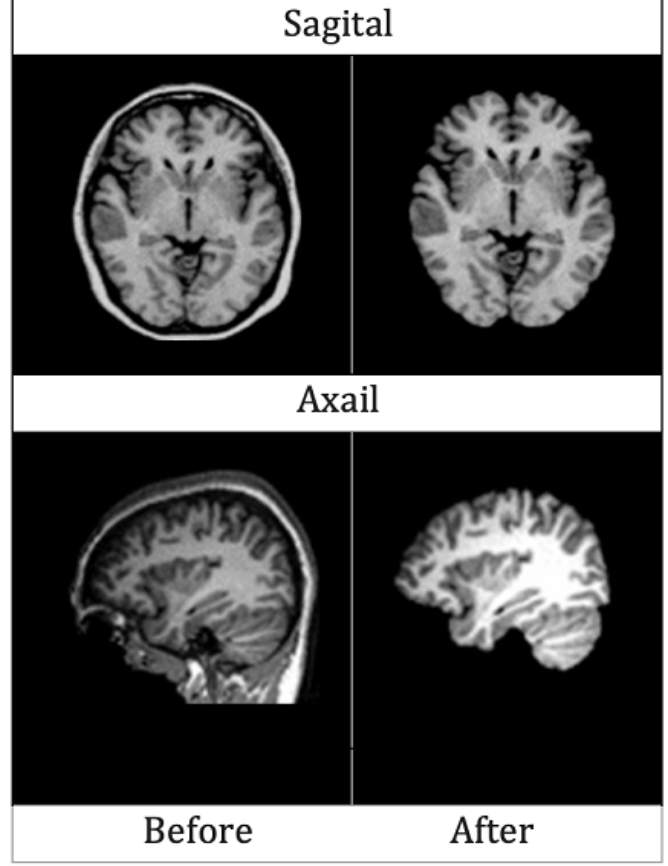
Figure 5. MRIs of Axial and Sagittal planes before and after skull striping.